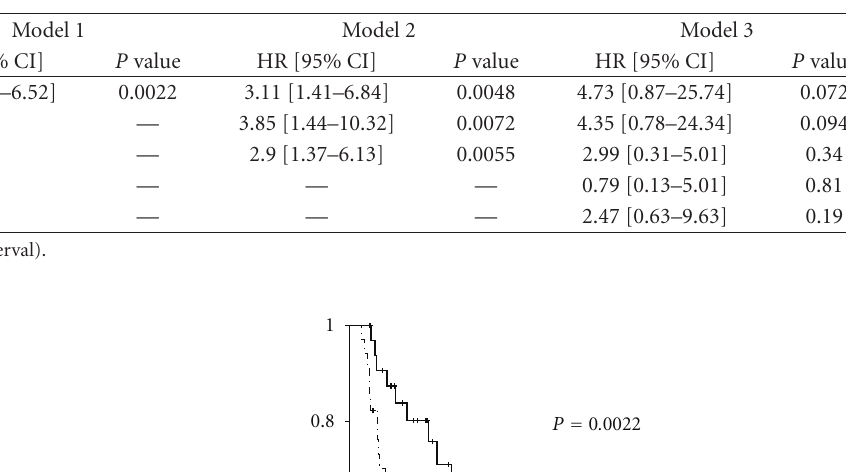
Table 3: E ff ect of anatomic location in univariable (model 1), multivariable analysis when adjusting for pre-treatment variables (model 2), and when adjusting for pre-treatment and treatment variables (model 3).